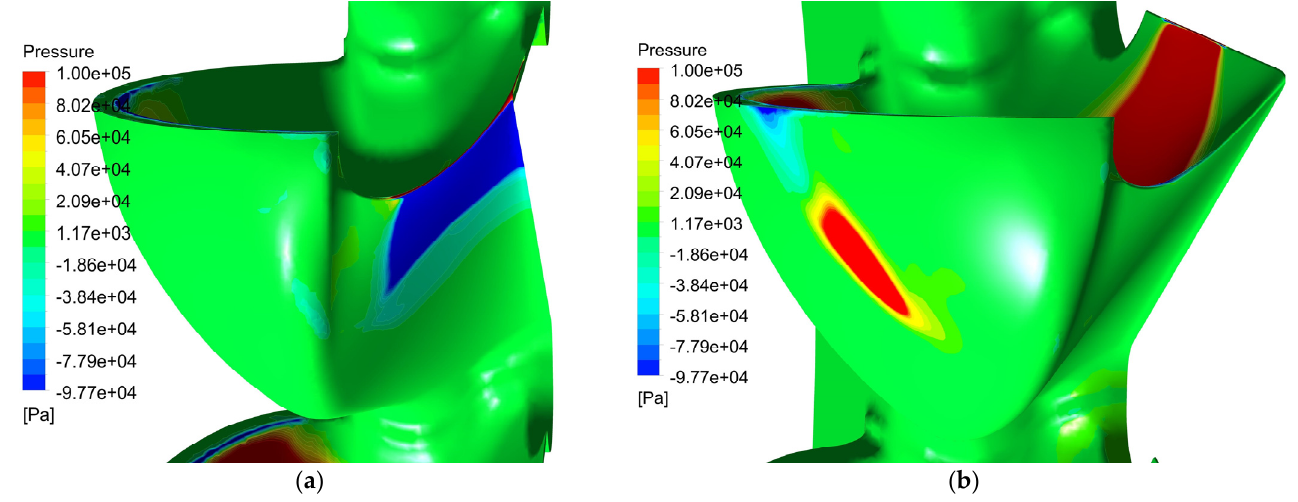
Figure 12. Pressure distribution on the runner exterior surface of the baseline design; ( a ) low pressure on the external cutout surface; ( b ) increased pressure on the lateral exterior bucket surface .